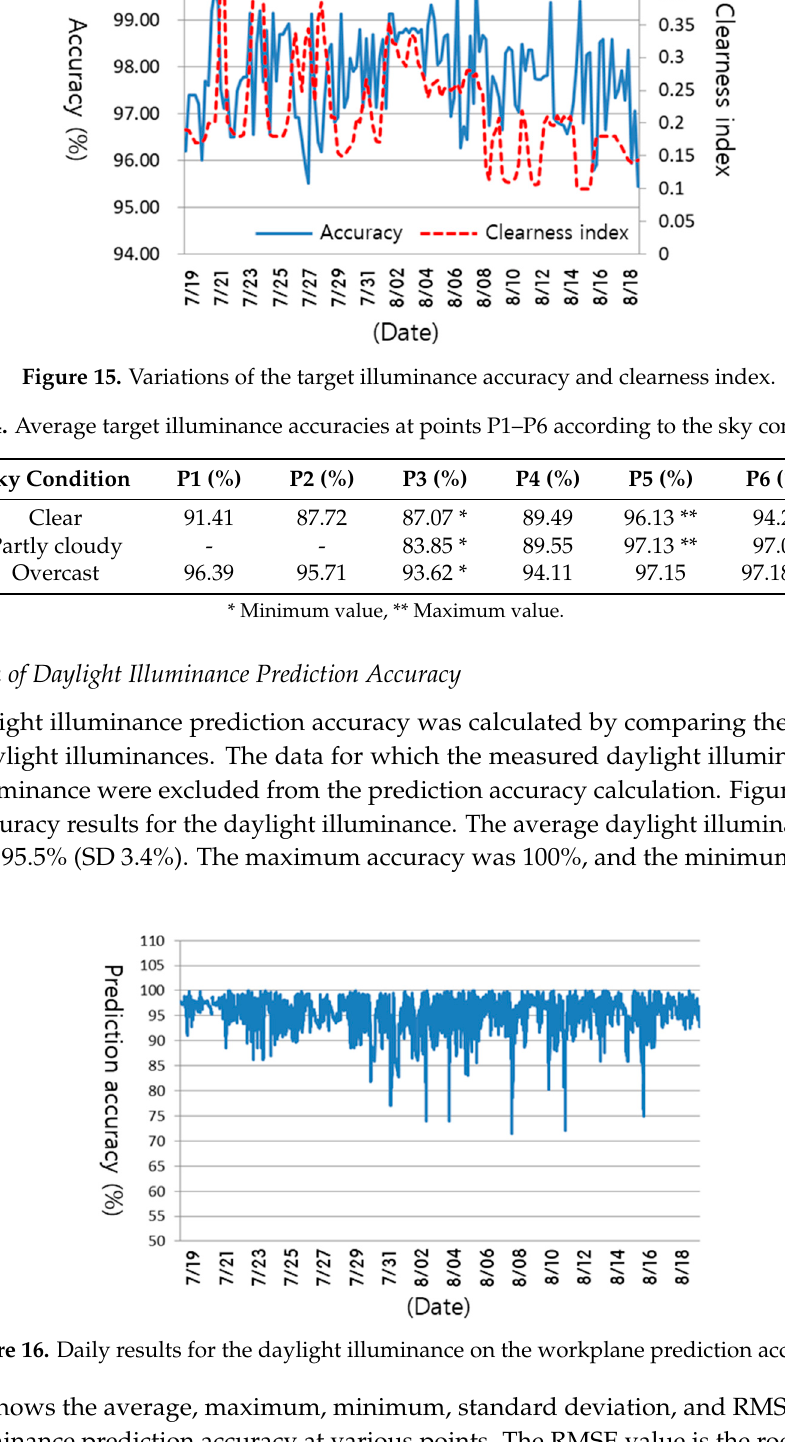
(f) Figure 17. Prediction accuracy of the daylight illuminance on the workplane at points ( a ) P1, ( b ) P2, ( c ) P3, ( d ) P4, ( e ) P5, and ( f ) P6. Table 5. Accuracy analysis for the prediction of the daylight illuminance on the workplane at points P1–P6.